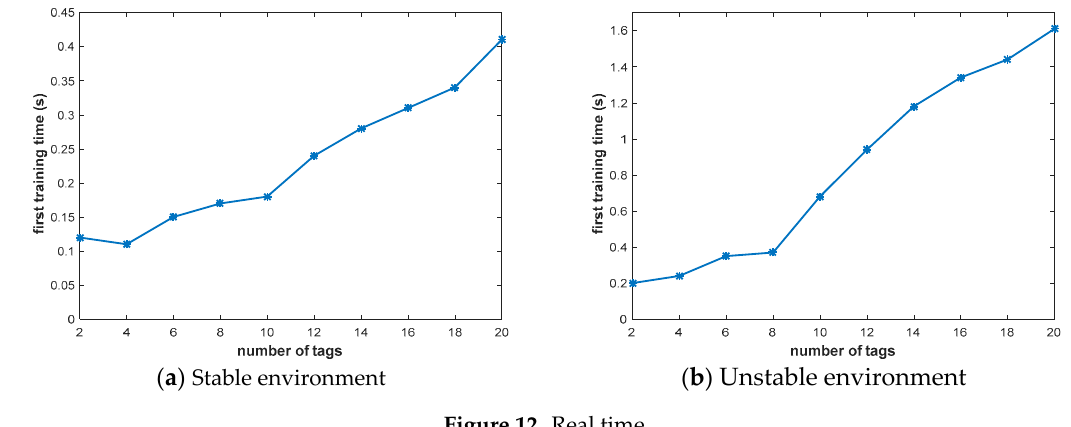
Figure 12. Real time.